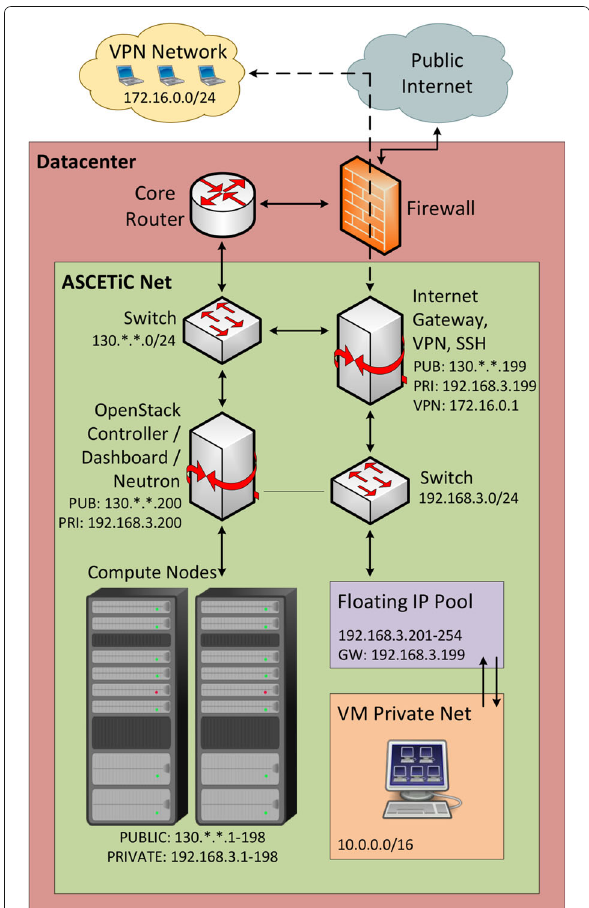
Fig. 7 Cloud Testbed Network